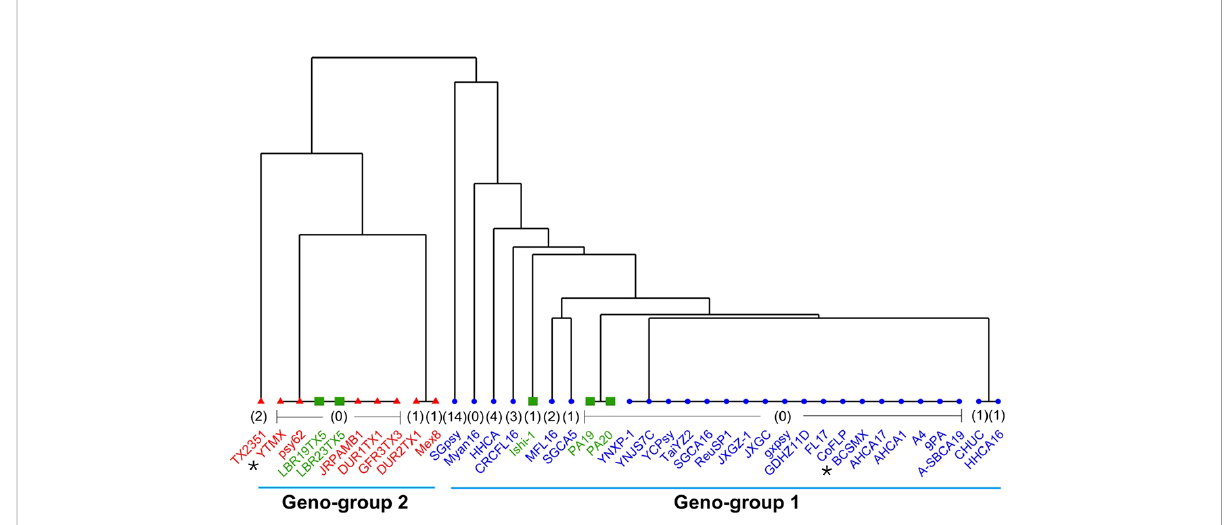
FIGURE 3 A dendrogram showing the Geno-group status of “ Candidatus Liberibacter asiaticus ” (CLas) strains with whole genome sequences available in GenBank based on concatenated SNPs from 15 TTS ( terL typing system) supportive genes. Strains in blue are in Term-A group; Strain in red are in Term-G group; and strains in green are non-typeable for Term-A or Term-G. The number in bracket indicates absent SNPs of that strain due to the incomplete nature of the draft genome sequence. The two Mexican CLas strains in this study are indicated by